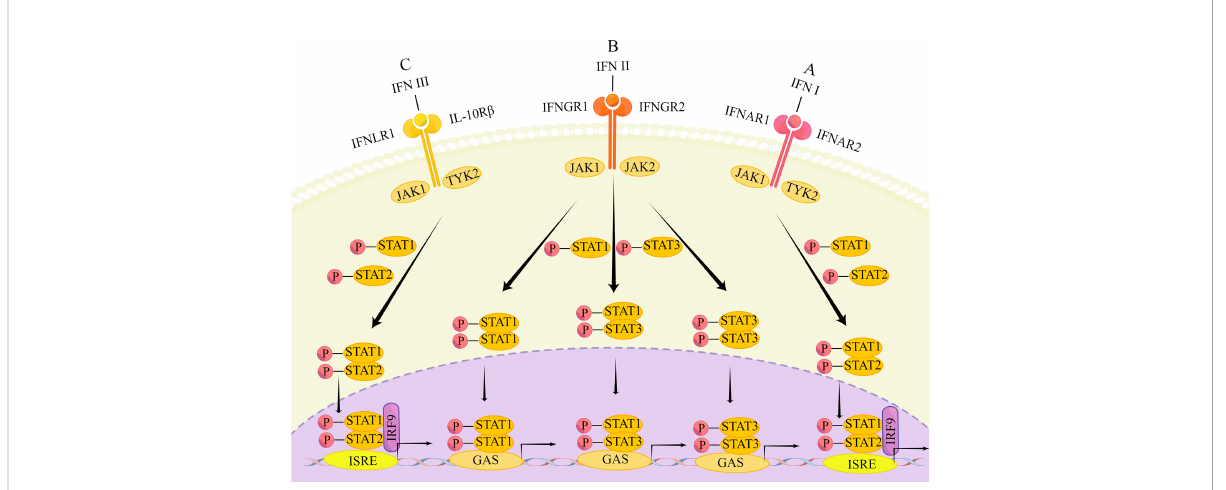
FIGURE 1 The main transduction pathway of IFN signaling. (A) IFN fi rst binds to the heterodimers of IFNAR1 and IFNAR2, causing phosphorylation of JAK1 and TYK2, followed by phosphorylation of STAT1 and STAT2. Phosphorylated STATs form heterodimers that enter the nucleus and bind to IRF9 to form ISGF3, which subsequently binds to the transcriptional enhancer ISRE, triggering transcriptional induction of ISG. (B) Type II IFNs fi rst bind to IFNGR1 and IFNGR2, causing phosphorylation of STAT1 and STAT2. The phosphorylated STAT forms a heterodimer that enters the nucleus and binds to IRF9 to form ISGF3. ISGF3 subsequently binds to the transcriptional enhancer ISRE, triggering the transcriptional induction of ISG. In addition, phosphorylated STAT1 homodimers, STAT3 homodimers and STAT1-STAT3 heterodimers enter the nucleus. These dimers bind to GAS elements to induce transcription factor production and initiate a second wave of gene expression; (C) Type III IFN binds to IFNLR1 and IL10R2, followed by the same response as the type I IFN signaling